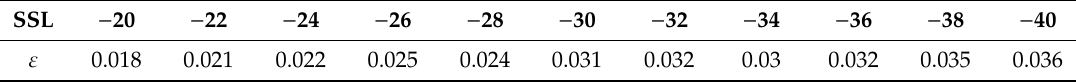
Table 4. Errors between the desired beam pattern and beam pattern of the V − OG − CS algorithm.